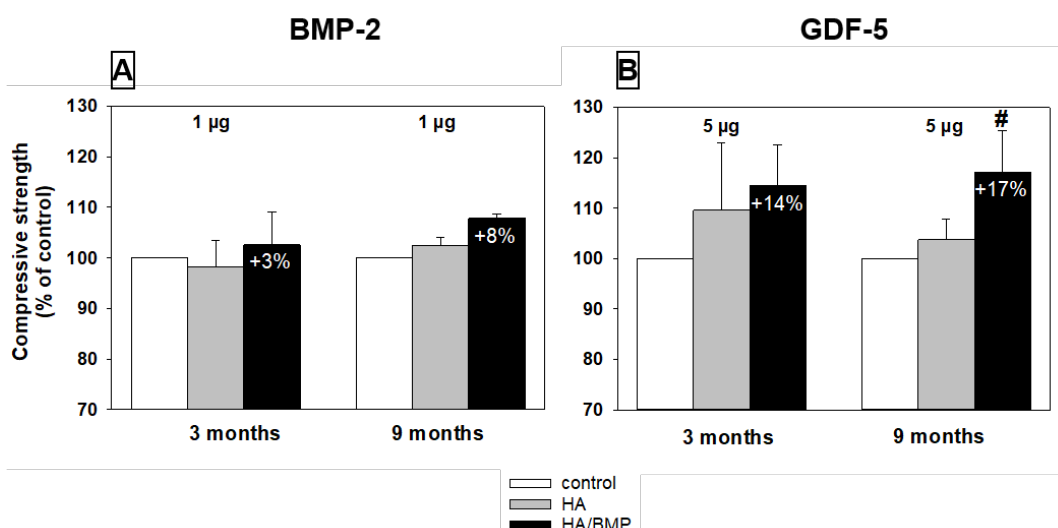
Figure 10. Relative increase of compressive strength (MPa; expressed as % of control) in lumbar vertebral bodies (L3 = control, L4 = HA/BMP; L5 = HA) of four selected groups (3 and 9 months; low-dose BMP-2 ( A ) or GDF-5 ( B )); p ≤ 0.05 Wilcoxon test; # for HA/BMP compared to non-injected control; the HA/GDF-5 particles induced a numerical 14% or significant 17% increase at 3 and 9 months, respectively.